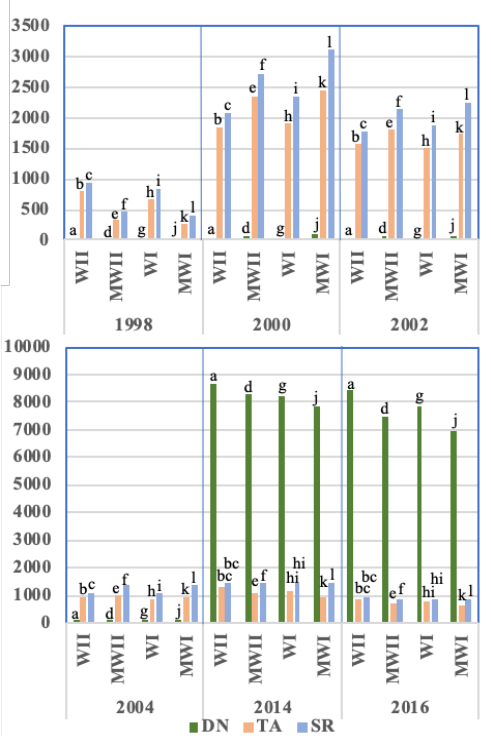
Figure 7. Average values of the Vegetation Index (NIR/R), Normalized Difference Vegetation Index (NDVI), and Simple Ratio Index (R/NIR) of the edge water class for three pre- processing levels (DN, TA, SR) across six years. Letters denote